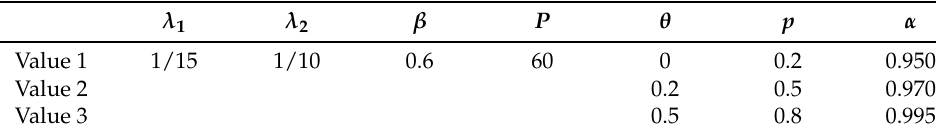
Table 1. Basic model parameters.